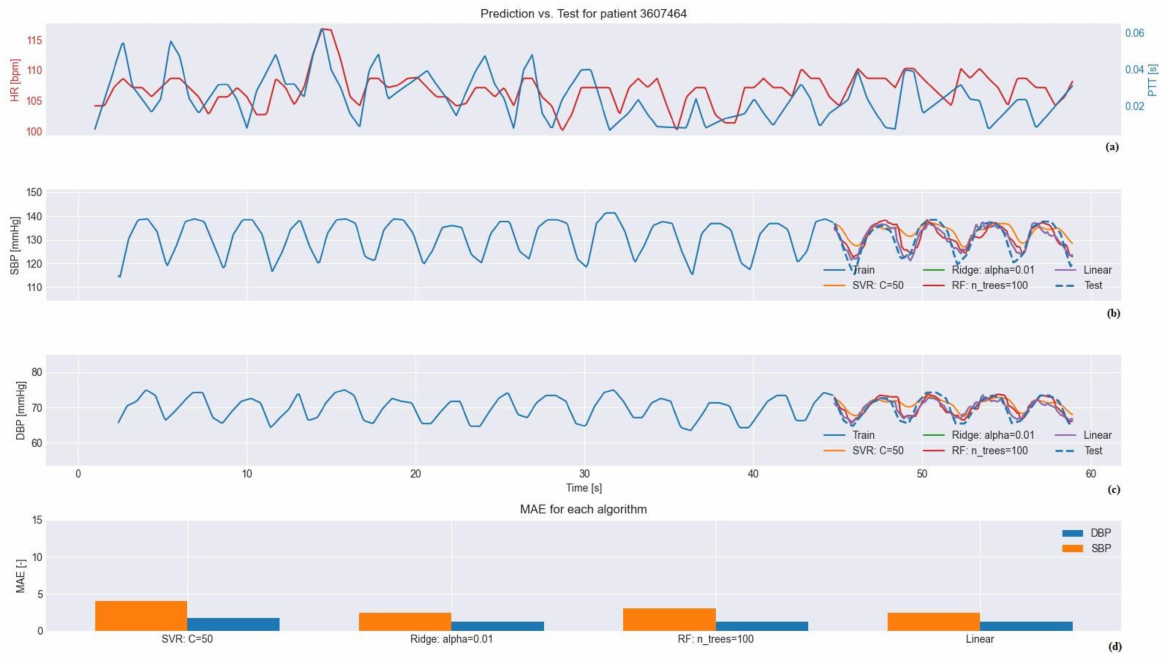
Figure 16. Training phase and test phase of the algorithms for signals from the MIMIC III database: ( a ) interpolation of the input values, ( b , c ) results of regression, and ( d ) MAE values for the se- lected measurement.